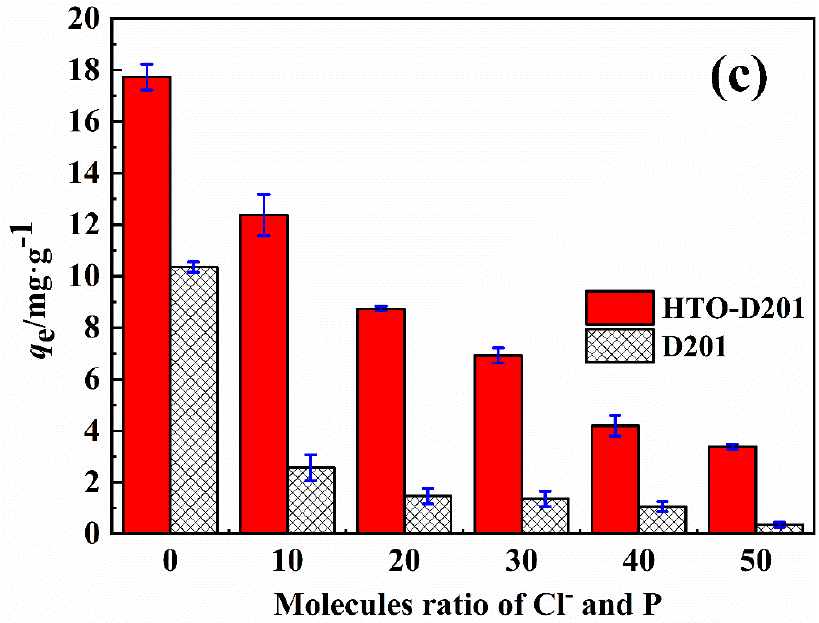
Figure 7. Factors of competitive ions on phosphate uptake by HTO-D201 and D201: ( a ) SO 42 − , ( b ) NO 3 − , ( c ) Cl −